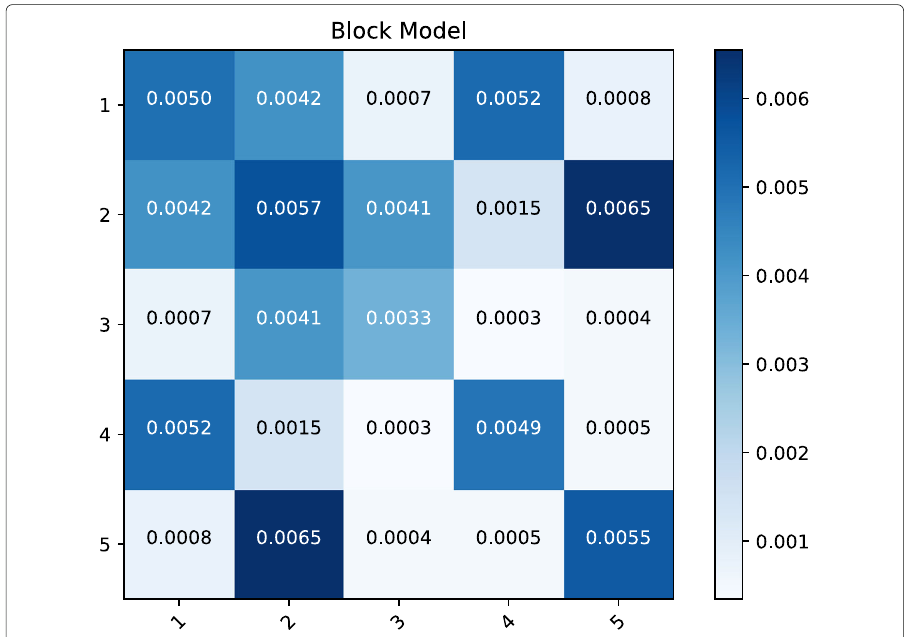
Fig. 9 The stochastic block model used to create the synthetic network. We synthesize edges between communities using the probabilities found in the respective